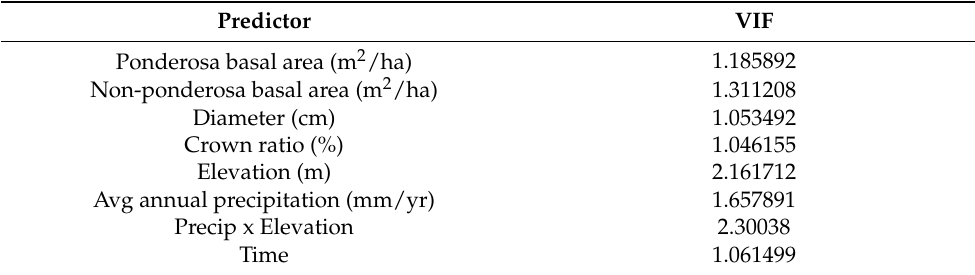
Table A6. Variance inflation factors (VIFs) calculated for each parameter from the final